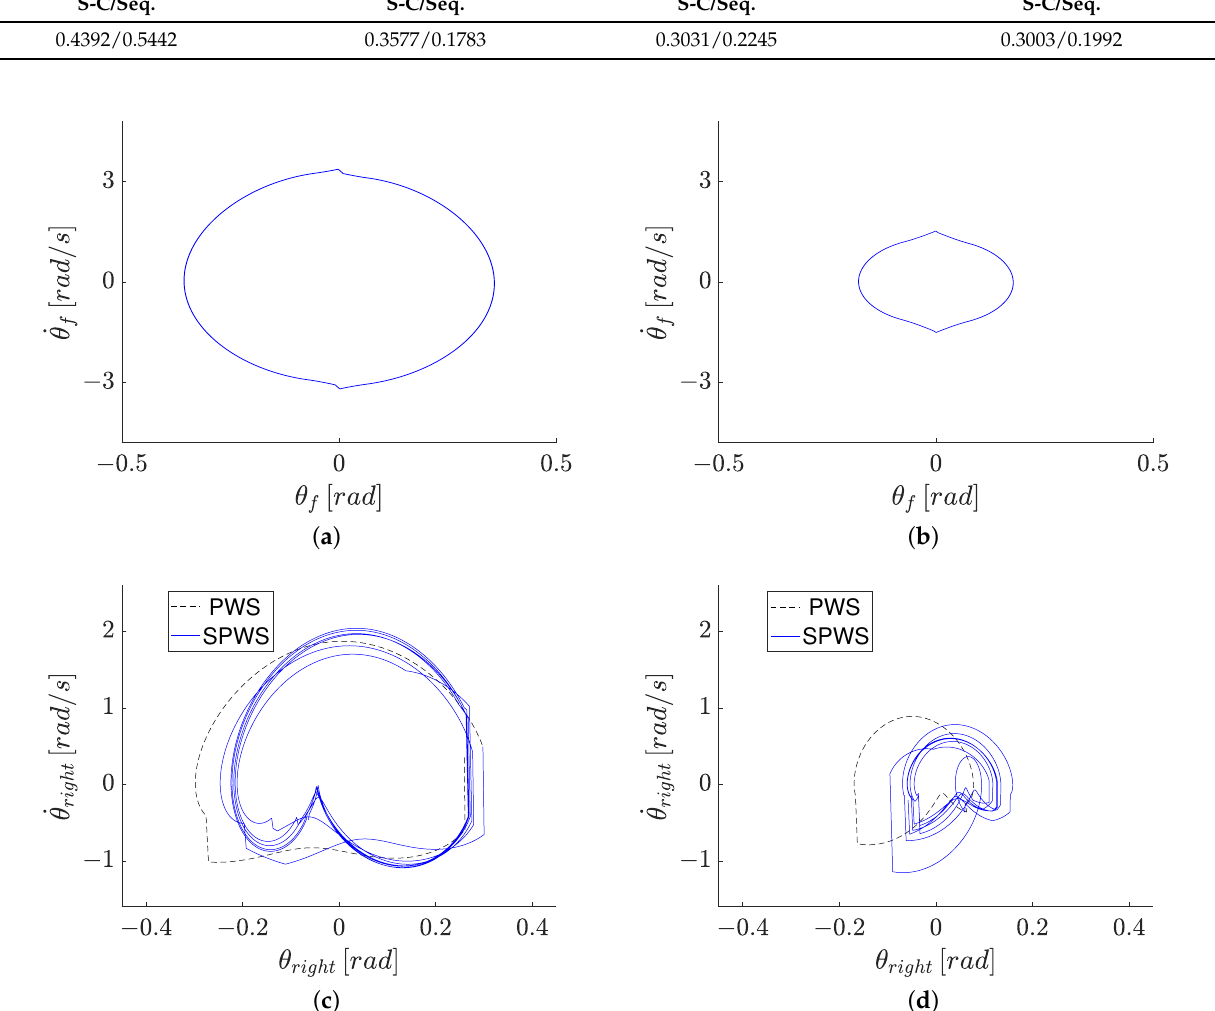
Table 9. Angular displacement indicators related to the best solutions of structure-control (S-C) and sequential (Seq.) design approaches. β fro (rad)